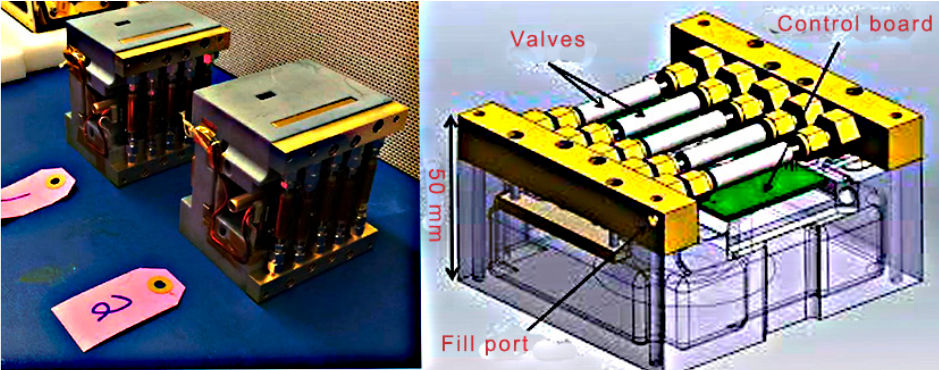
Figure 7. CubeSat cold gas thruster.